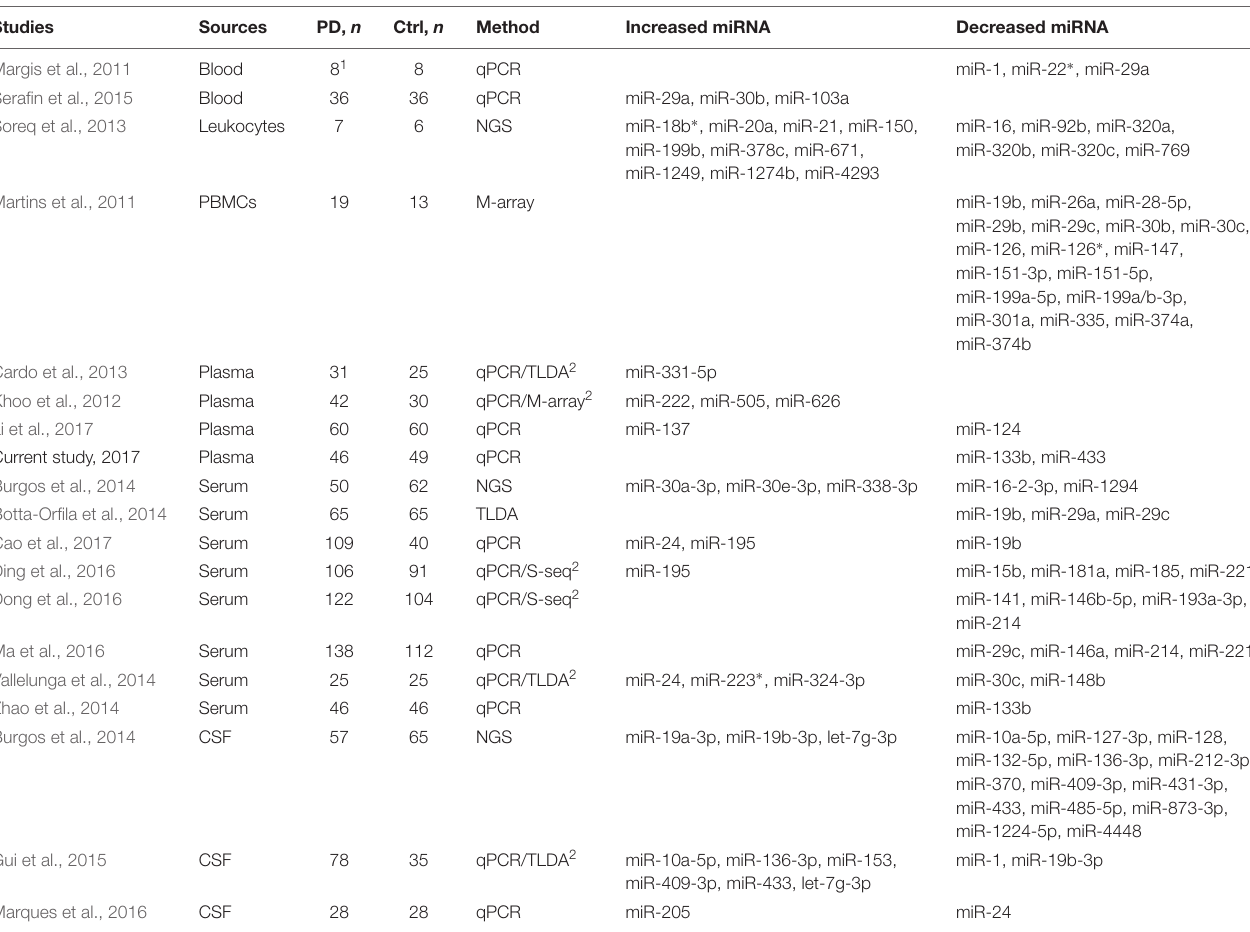
TABLE 3 | Aberrant expression of miRNAs in fluids or blood cells of PD